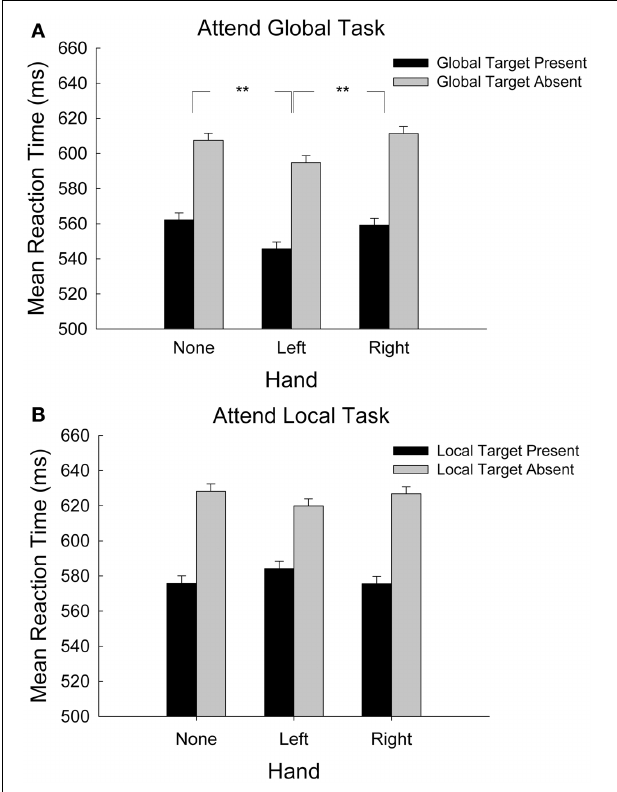
FIGURE 2 | (A) Mean response time during the attend-global task, where global targets were present or absent, plotted by hand-presence condition. Error bars represent standard error of the mean. (B) Mean response time during the attend-local task, where local targets were present or absent, plotted by hand-presence condition. Error bars represent standard error of the mean ∗∗ p < 0 .